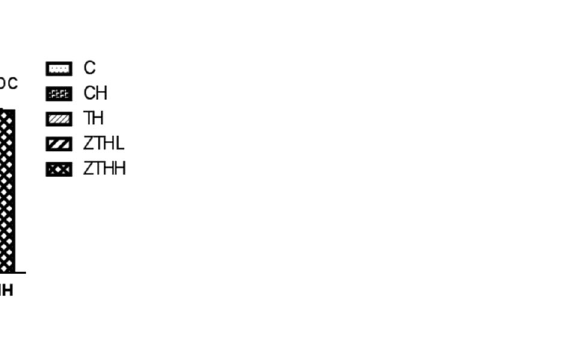
Figure 6. Glucose area under the curve during oral glucose tolerance test (OGTT) (n = 10, mean and SEM). a Vs C-group, p < 0.05; b vs CH-group, p < 0.05; c vs